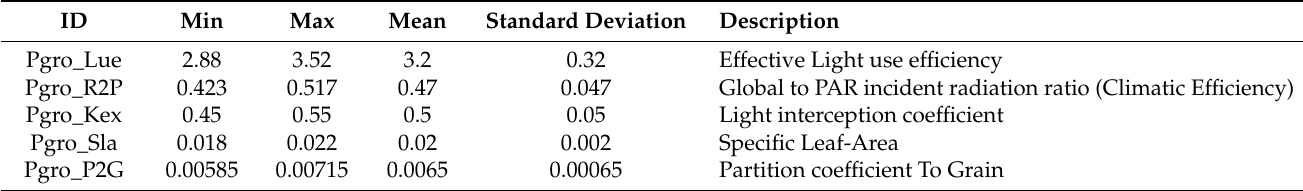
Table 6. List of parameters that vary in